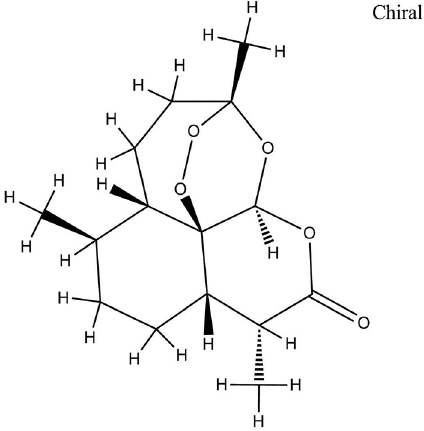
FIGURE 1 - The structure of arteannuin downloaded from PubChem (CID: